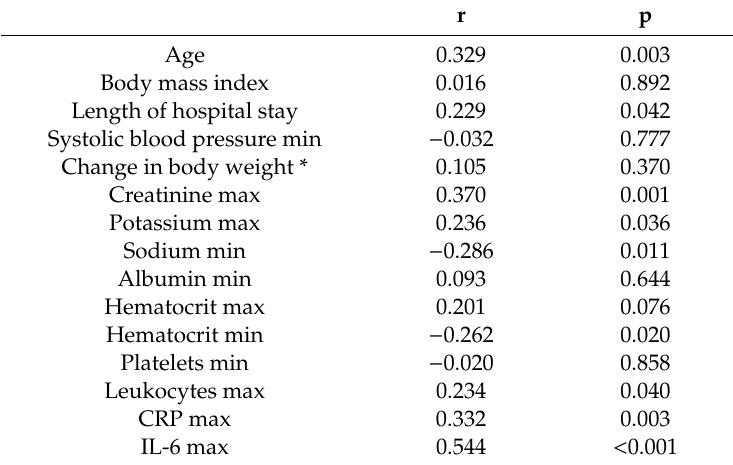
Table 2. Correlations of plasma YKL-40 with clinical and laboratory variables in 79 patients with Puumala hantavirus infection. r p Age 0.329 0.003 Body mass index 0.016 0.892 Length of hospital stay 0.229 0.042